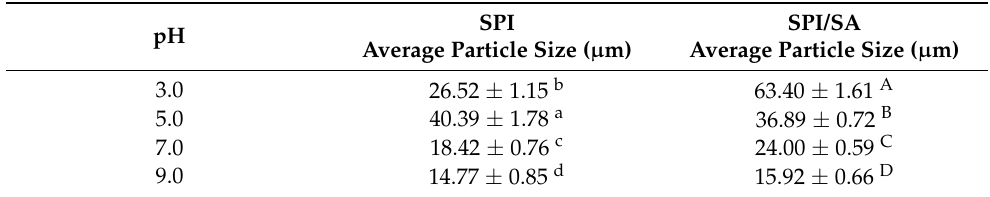
Table 1. The average particle size of SPI and SPI/SA microparticles at different pH values. SPI pH